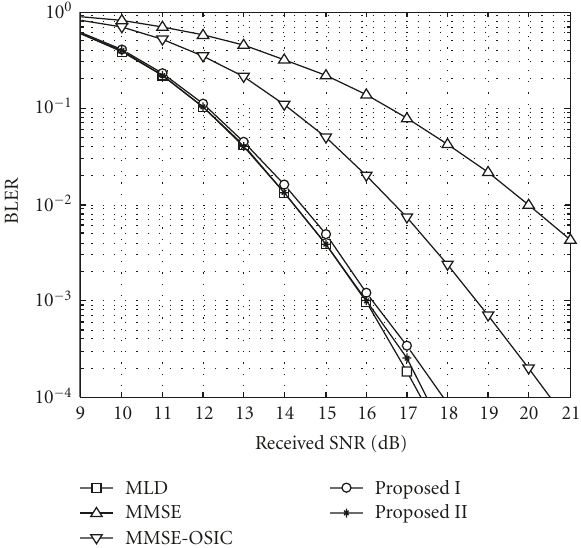
Figure 11: Comparison of the BLER performance of the first PSS for the proposed and the conventional schemes when the MCS combination is { (16QAM, 3/4), (QPSK, 3/4) }